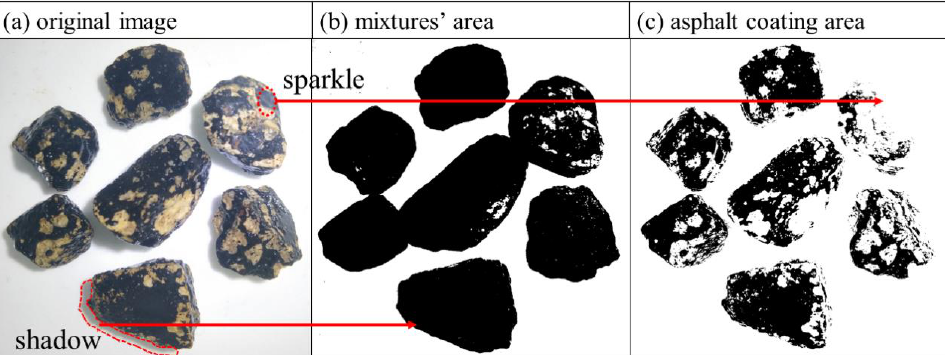
Figure 6. Image analysis method. Materials 2019 , 12 , x FOR PEER REVIEW